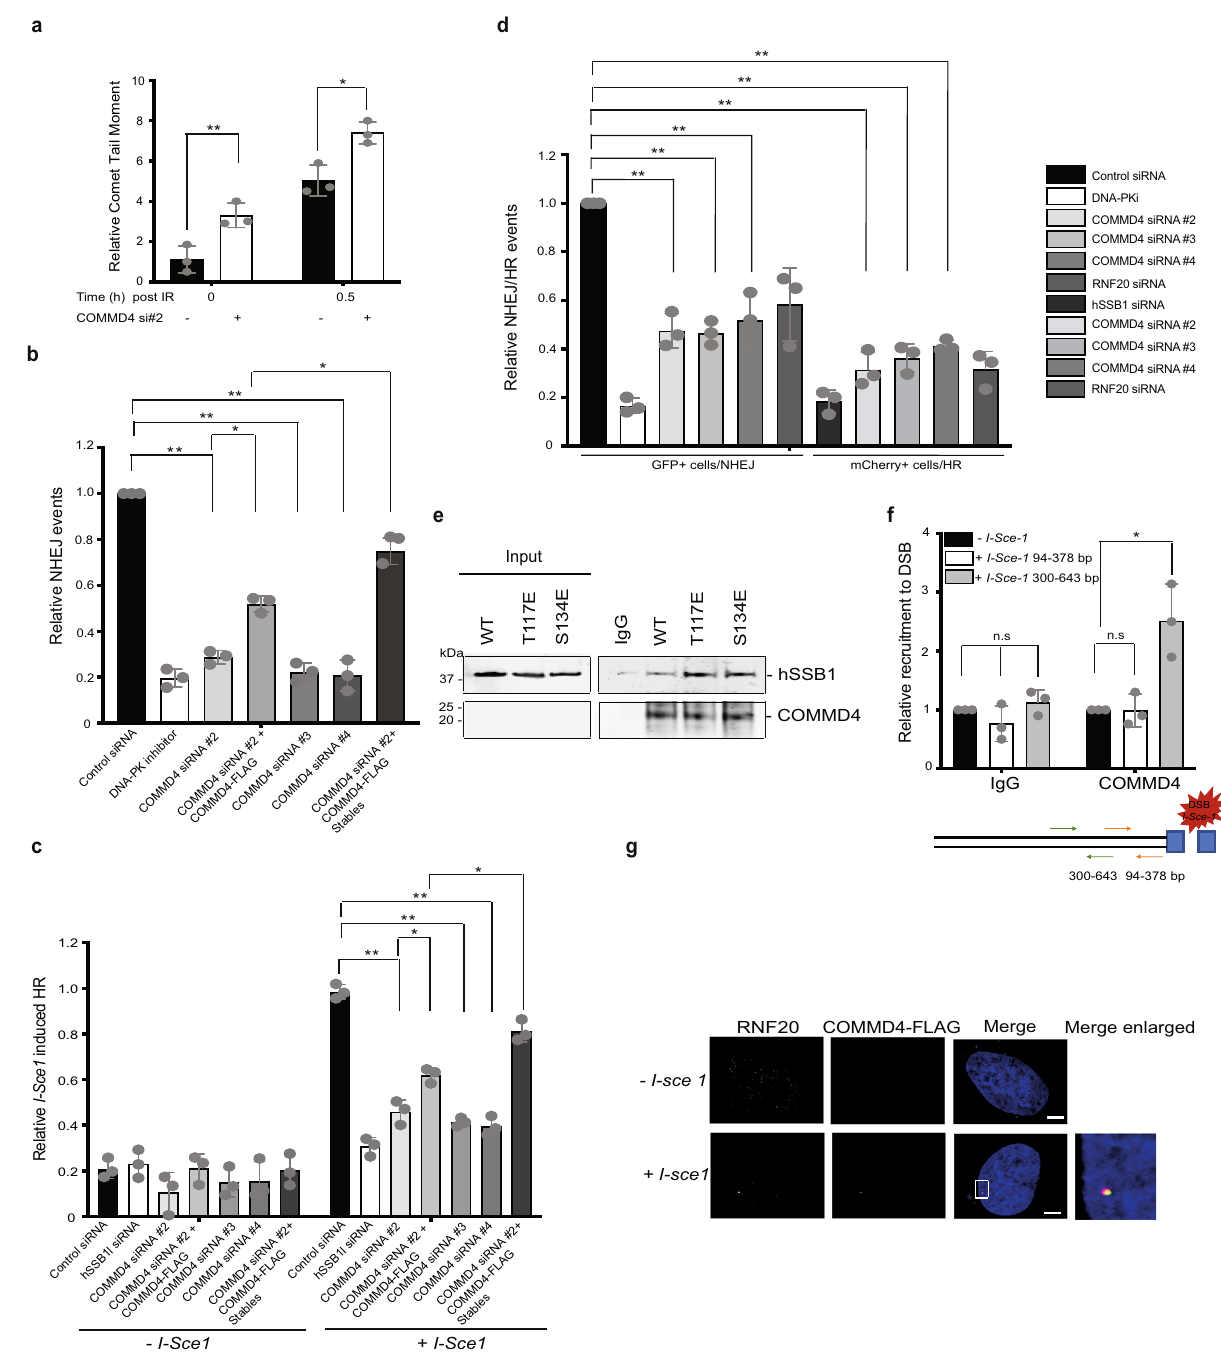
Fig. 2 Repair of DNA double-strand breaks in COMMD4-depleted cells and interaction with hSSB1. a Comet assay showing the relative comet tail moment in COMMD4-de fi cient and control cells at 0 and 0.5 h post treatment with 6 Gy IR. b Plot of the relative NHEJ events in control, cells treated with DNA-PK inhibitor, COMMD4-depleted cells, COMMD4-depleted cells transiently overexpressing COMMD4-FLAG and cells stably expressing COMMD4- FLAG, 48 h post-transfection with HindIII linearised EGFP-N3 plasmid. c Plot of I-Sce1 induced HR in control, hSSB1-depleted, COMMD4-de fi cient cells and COMMD4-de fi cient cells overexpressing COMMD4-FLAG transiently and stably. d Plot of the relative NHEJ and HR events, respectively, in control, DNA-PK inhibitor, hSSB1 siRNA and COMMD4-depleted cells using a quantitative reporter assay that measures NHEJ versus HR in the same cells through the repair of two inverted I-Sce1 cuts. e A direct interaction between COMMD4 and WT hSSB1, T117E and S134E hSSB1. COMMD4 was used to pull-out the protein complexes. IgG is the negative control and COMMD4 shows the loading. f ChIP-qPCR assay with primers at 94 – 378 and 300 – 643 bp from the break-site in DRGFP cells transfected with COMMD4-FLAG, ± I-Sce1 . The enrichment of COMMD4 after induction of a DSB was compared to the IgG control and - I-Sce1 sample. Signi fi cant recruitment was only observed at 300 – 643 bp. The schematic of the assay and the primer pairs used is shown below. * p < 0.05, ** p < 0.005, ns non-signi fi cant where p > 0.05. Error bars represent mean ± SD from three independent experiments. g Immuno fl uorescence showing localisation of FLAG-COMMD4 and RNF20 at a DSB induced by the I-SceI restriction enzyme in MCF7 DRGFP cells. Scale bar denotes 5 μ